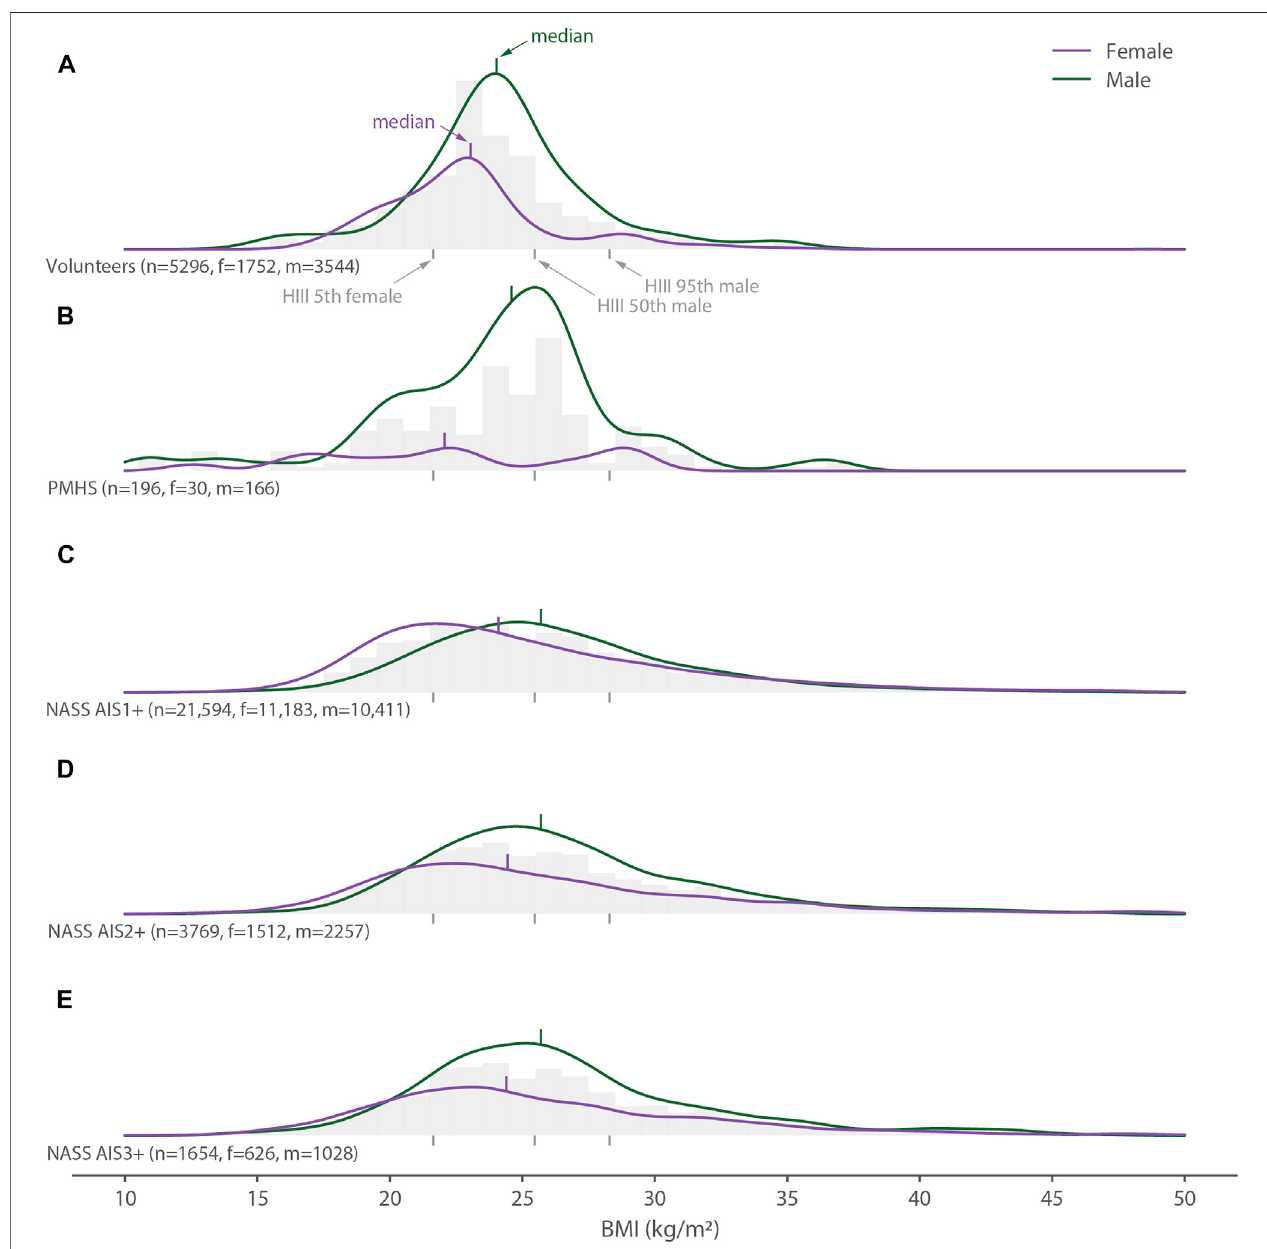
FIGURE 5 | Distribution of all body mass index (BMI) data (gray histograms), females (purple lines) and males (green lines) for (A) the volunteer tests, (B) the PMHS tests, (C) the NASS AIS1+ data, (D) the NASS AIS2+ data, and (E) the NASS AIS3+ data. The gray vertical bars below each histogram show the heights of the 5th percentile female, 50th percentile male and 95th percentile male Hybrid III crash test